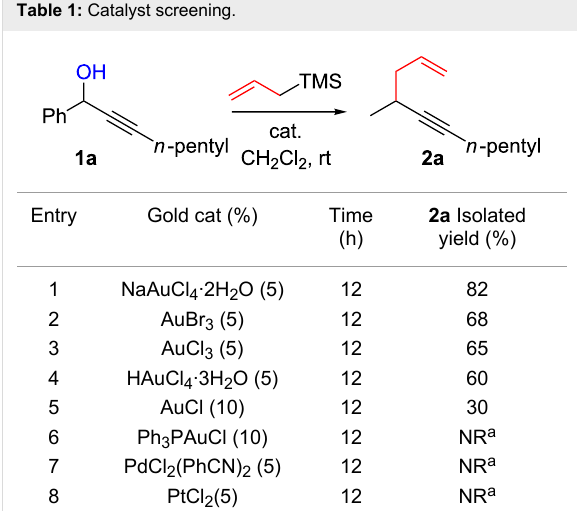
Table 1: Catalyst